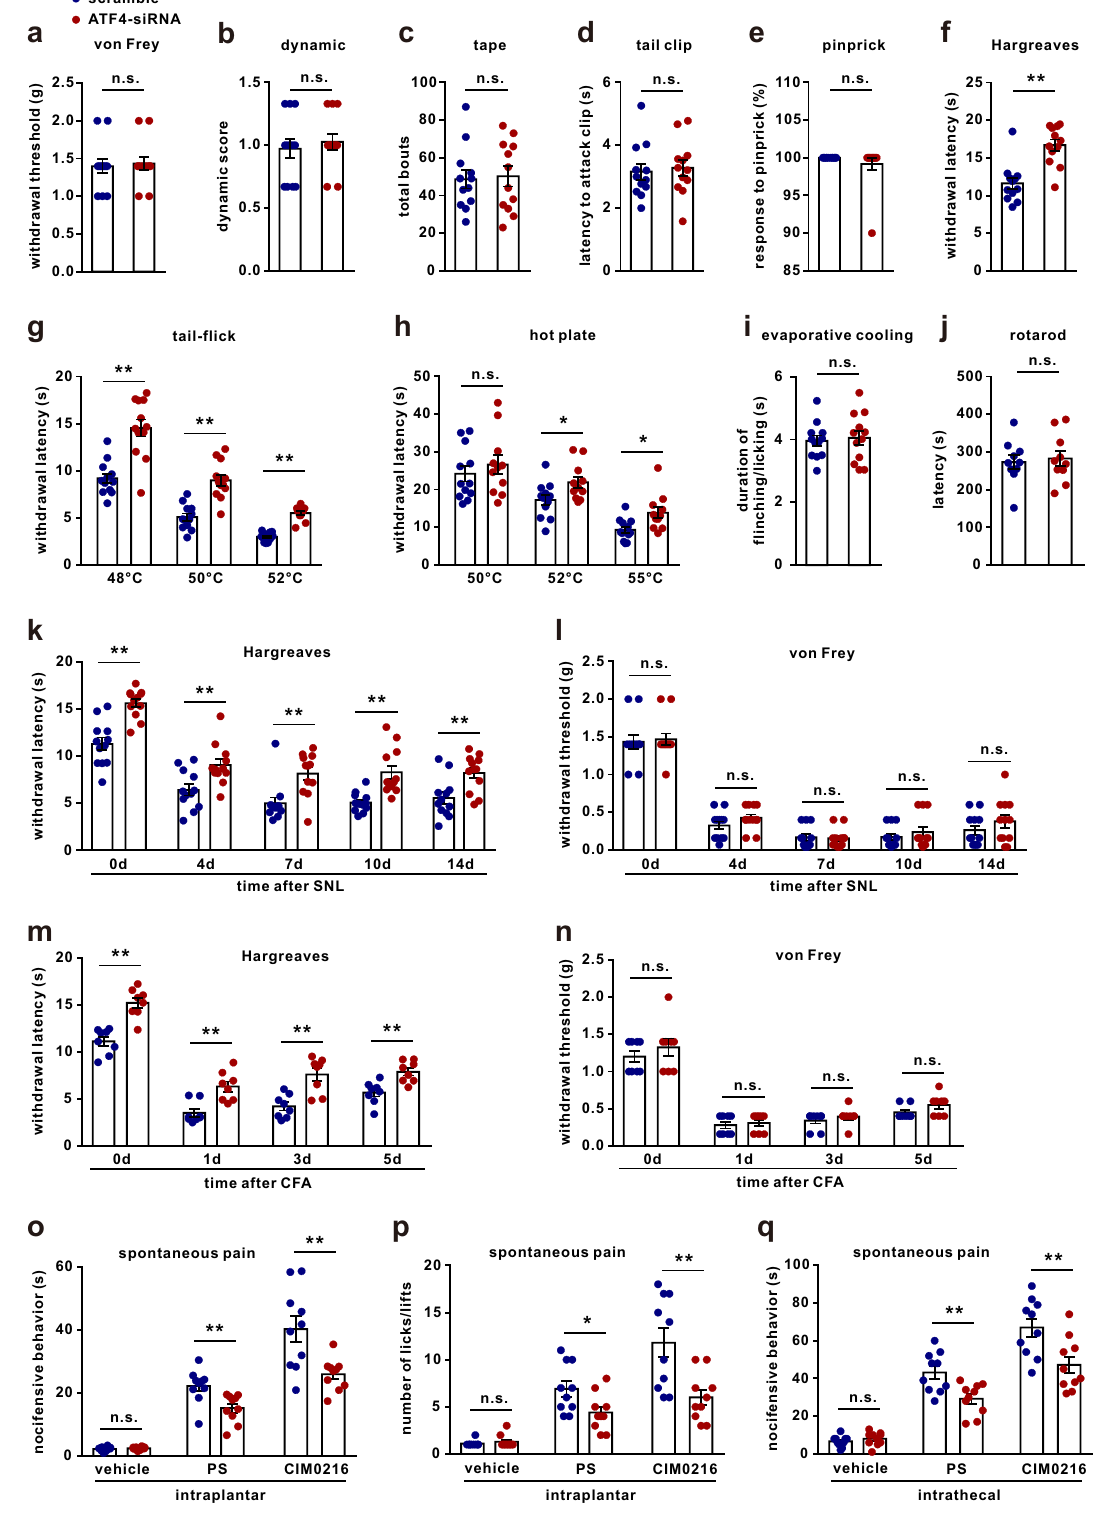
(Fig. 5b) but no change in total TRPM3 levels (Fig. 5c) were observed in DRG tissues from Atf4 + / − mice compared to those from WT mice. The ratio of TRPM3 traf fi cking was also sig- ni fi cantly decreased in the DRGs of Atf4 + / − mice compared to those of WT mice (Supplementary Fig. 5h). Surface biotinylation analysis revealed a reduction in TRPM3 surface expression in